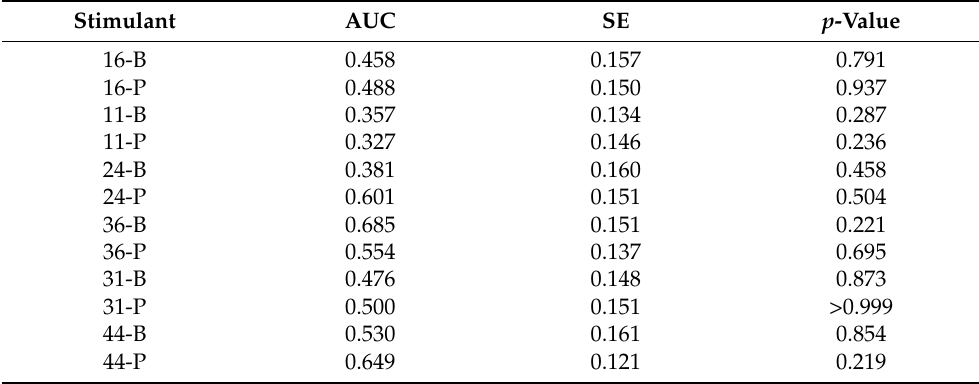
Table 4. Results of ROC analysis for gingival crevicular fluid volume.